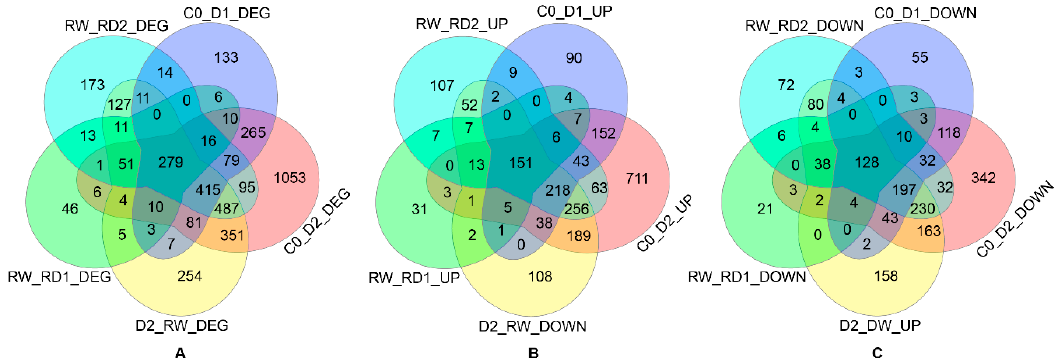
Figure 1. ( A ) differentially expressed genes (DEGs) in drought, rehydration and re-drought treatments; ( B ) DEGs of upregulated in drought and re-drought treatment and downregulated in rehydration; ( C ) DEGs of downregulated in drought and re-drought treatment and upregulated in